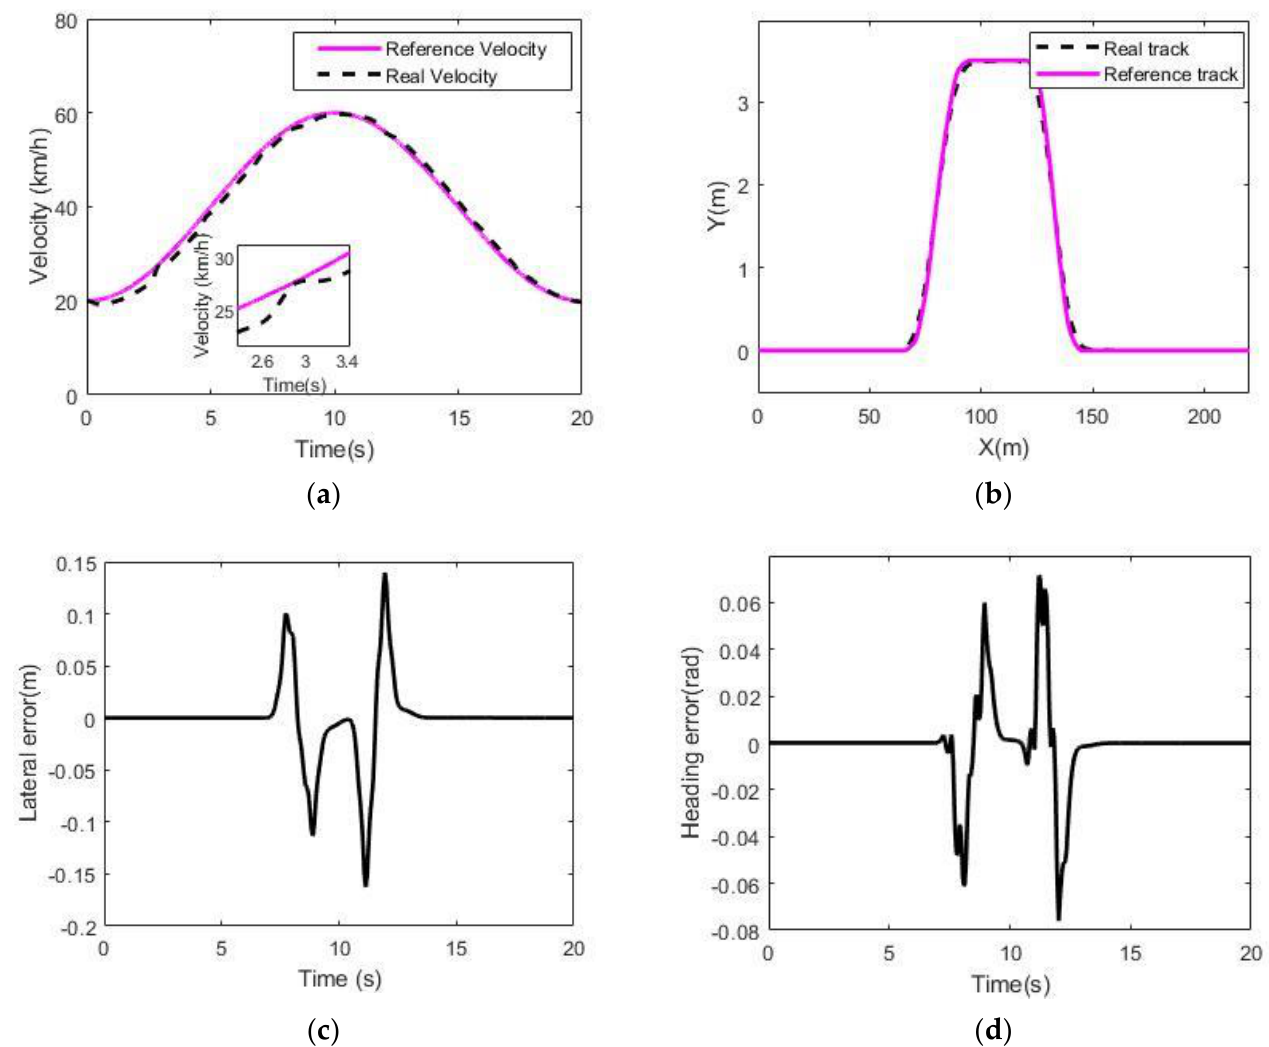
Figure 4. Vehicle state and tracking error: ( a ) velocity; ( b ) vehicle location; ( c ) lateral error; ( d ) heading error.